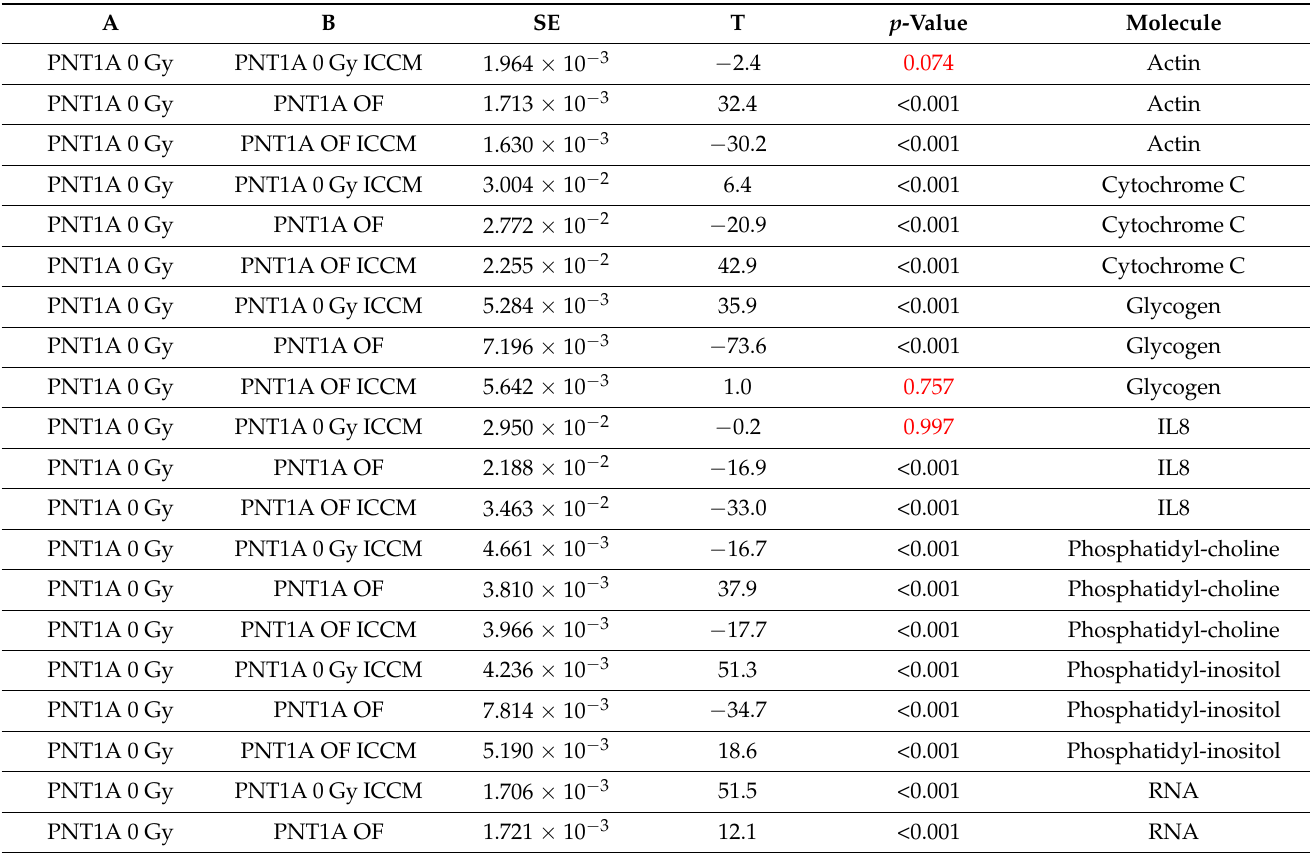
Table 2. Results of post hoc pairwise testing with the Games-Howell approach on CLS coefficients from fitting of PNT1A cell spectra. Column A and B of the table identify the paired classes which are compared for each molecule, with SE denoting the standard error on the mean and T the t-statistic. Non-significant p -values at the level of p < 0.001 are highlighted in